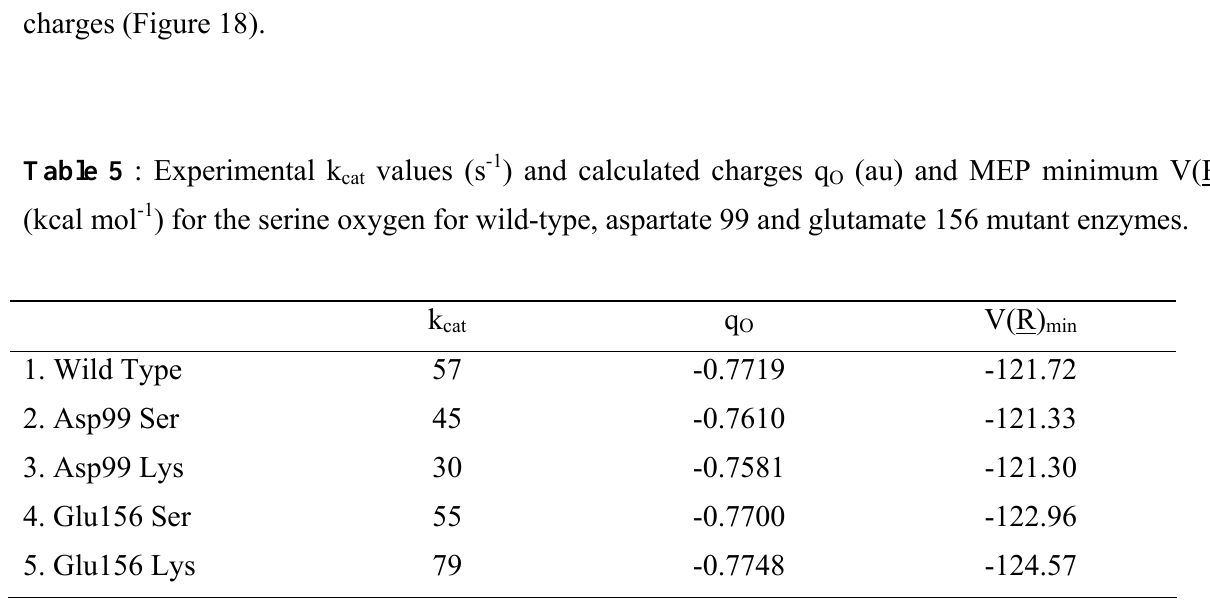
(au) and MEP minimum V(R) O